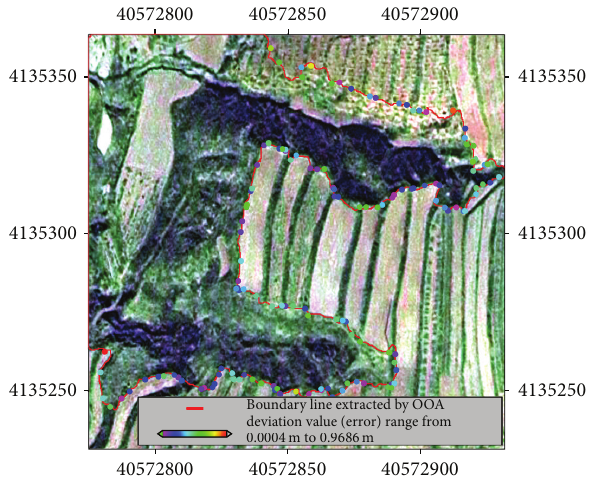
Figure 7: Comparison between gully boundary line extracted by OOA (red line) and RTK-GPS fielded measurement points coloured withtheoffsetfromgullyboundarylineextractedbyOOA(redline).